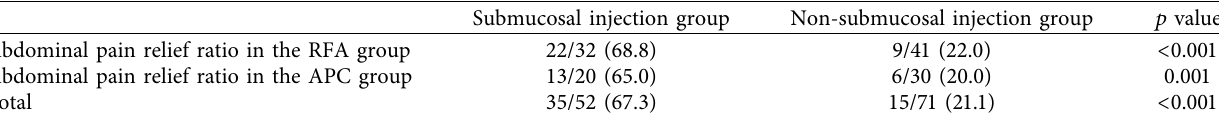
Table 2: Submucosal injection for postoperative abdominal pain